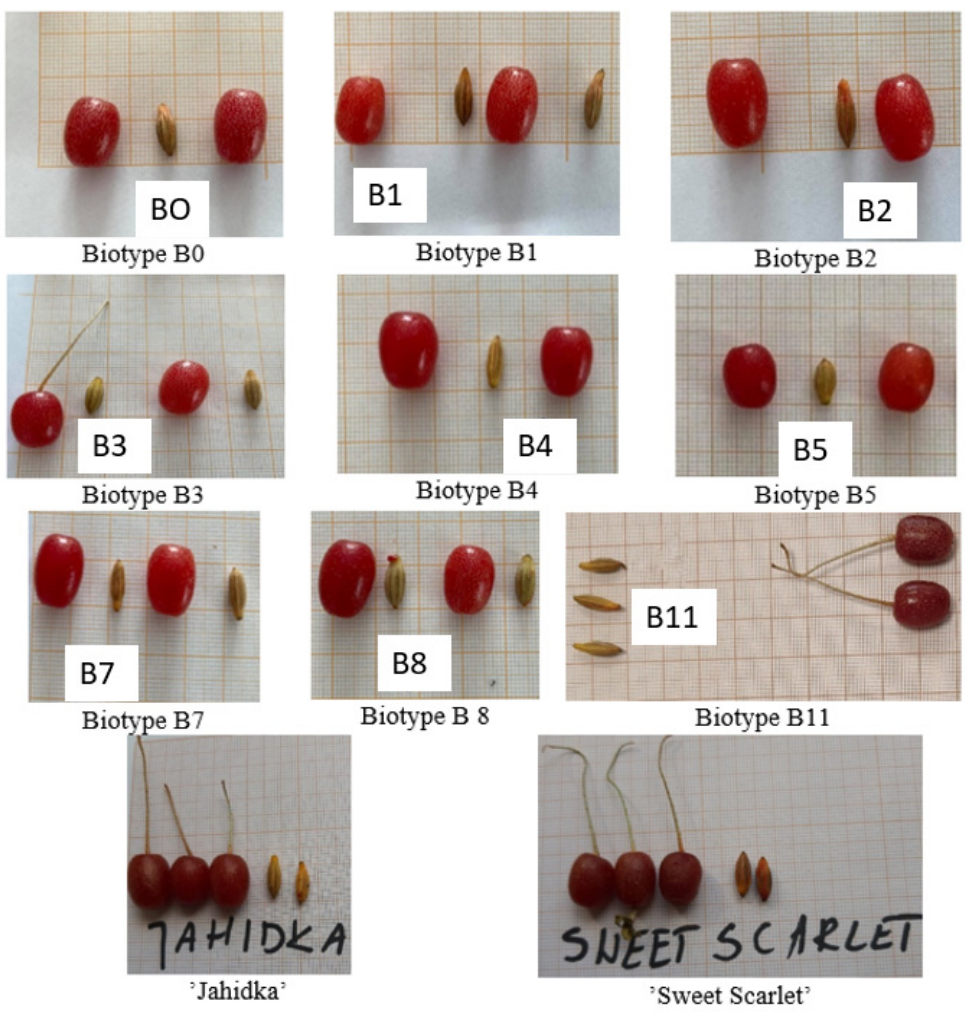
Figure 1. Fruits and seeds of the biotypes and cultivars of Elaeagnus multiflora studied.